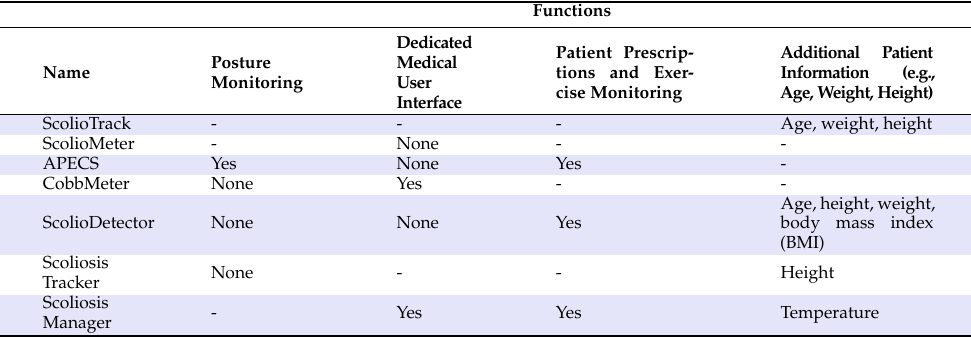
Table 3. Comparison of the tools with respect to the functions macro-category. Note that only Cobb- Meter has a dedicated medical user interface because it is intended for the spinal care professional. “-” means the information is not available.